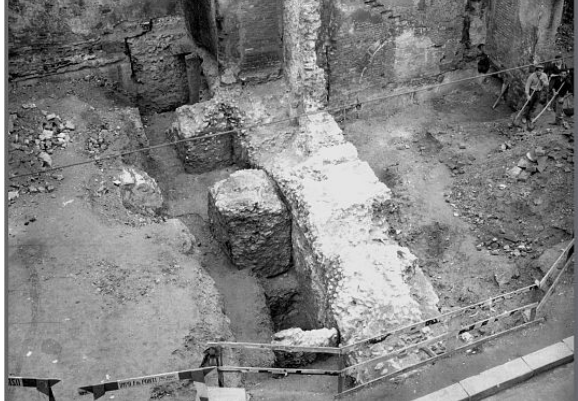
Figure 5. Elevated View of the remains of the three pillars of the Circus foundations, Via Circo – 1959 (Courtesy of